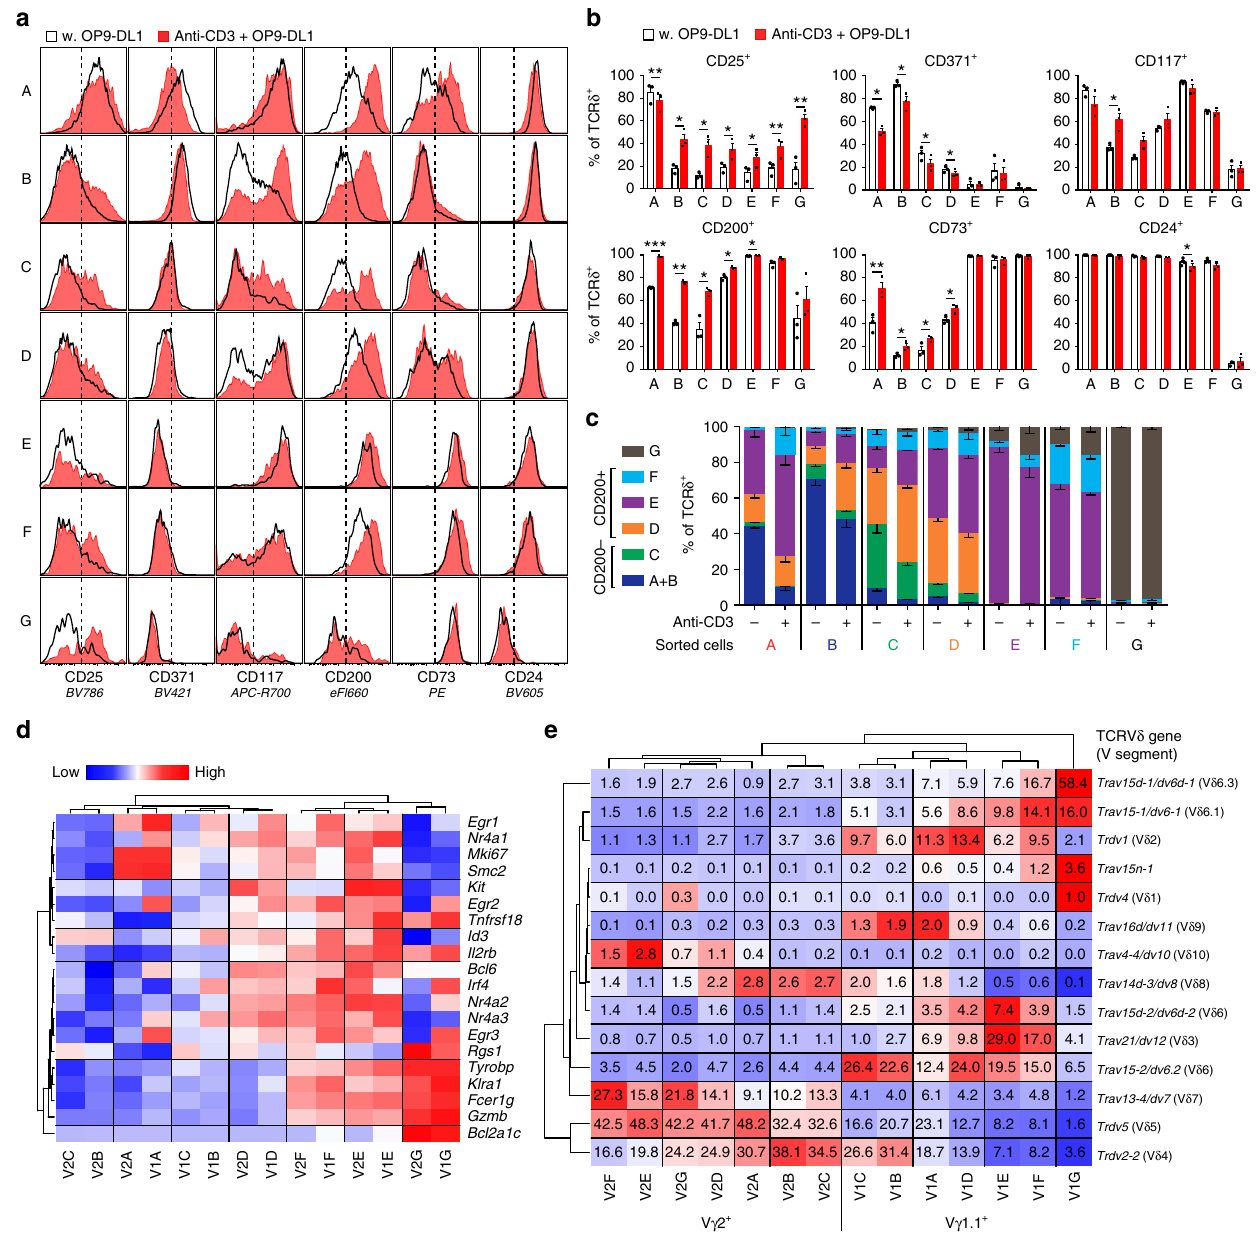
Fig. 4 Progression through the D, E and F populations is induced by TCR signalling. a – c Changes in surface marker expression of TCR δ + cells from sorted population A to G cells after 2 days of culture on OP9-DL1 monolayers in the presence or absence of immobilised anti-CD3. The data are visualised as a histograms and b bar plots of the percentage of cells positive for each individual marker as well as c gated into the A to G populations. Bars depict the mean ± SEM from three independent experiments with cells sorted from four to eight mice. Statistical analyses were performed using the paired two-sided Student ’ s t test, with signi fi cance de fi ned as * p < 0.05; ** p < 0.01; *** p < 0.001. d Heat map showing expression of genes reported to be induced by γδ TCR signalling during development within the A to G populations of the V γ 1.1 + (V1A – V1G) and the V γ 2 + (V2A – V2G) subset. e TCR δ repertoire of cells within the A to G populations of the V γ 1.1 + and the V γ 2 + subset. Numbers and colour depict the mean percentage of RNA-Seq reads aligned to the TCR δ locus from two independent RNA-Seq libraries, each constructed from RNA isolated from 24 mice across three independent cell sorting surface phenotype. This fi nding indicates that the cells in the C population are likely progenitors of γδ Tn cells.